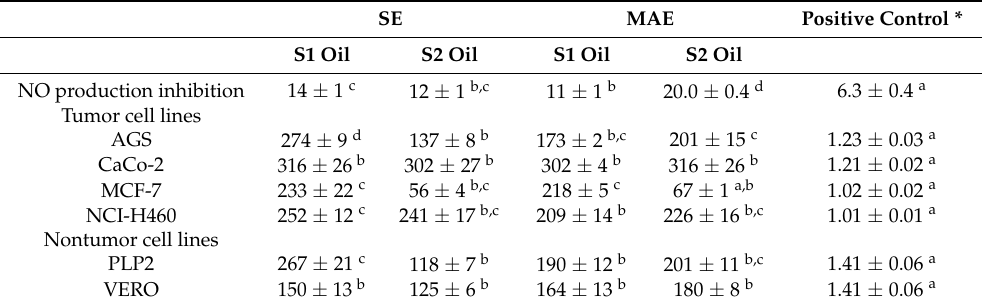
Table 6. NO production inhibition capacity (IC 50 values, µ g/mL) and cytotoxic activity to tumor and non-tumor cell lines (GI 50 values, µ g/mL) of the oils extracted from fish by-products through Soxhlet extraction (SE) and optimized microwave-assisted extraction